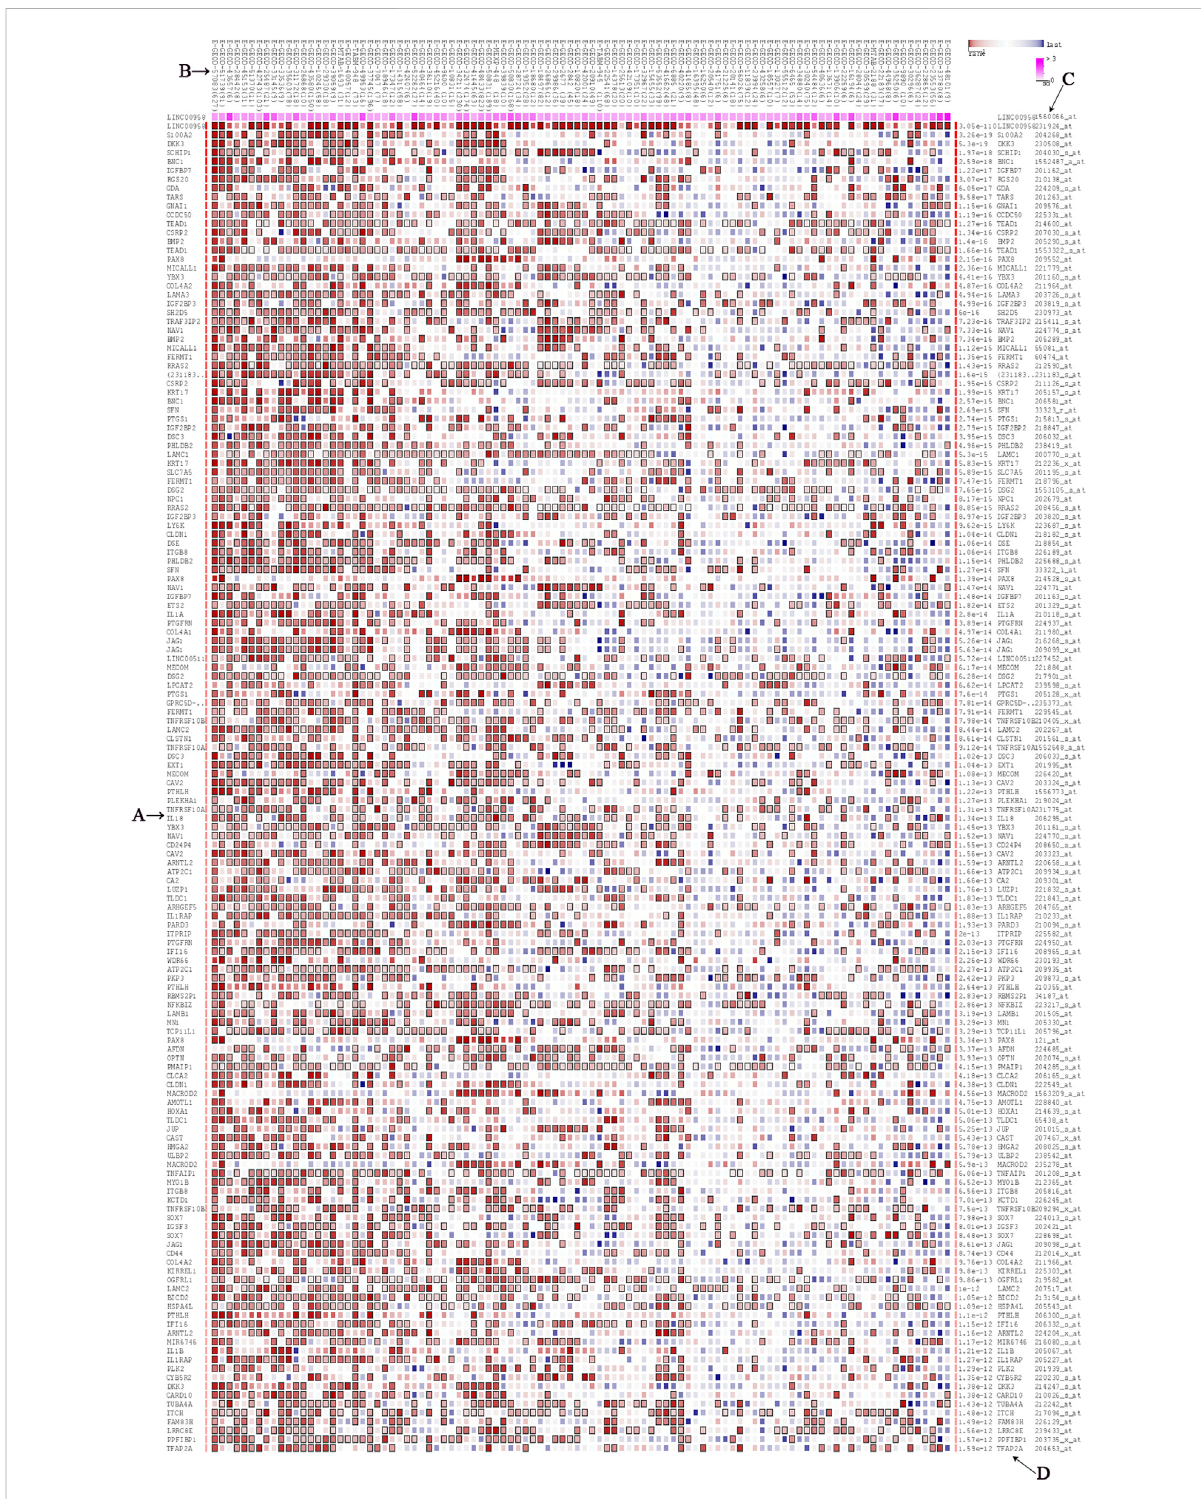
FIGURE 9 The top 150 predicted target genes of LINC00958 by using Multi Experiment Matrix (MEM, http://biit.cs.ut.ee/mem/) website. (A) predicted target genes; (B) Single experimental data set; (C) Gene probes; (D) p